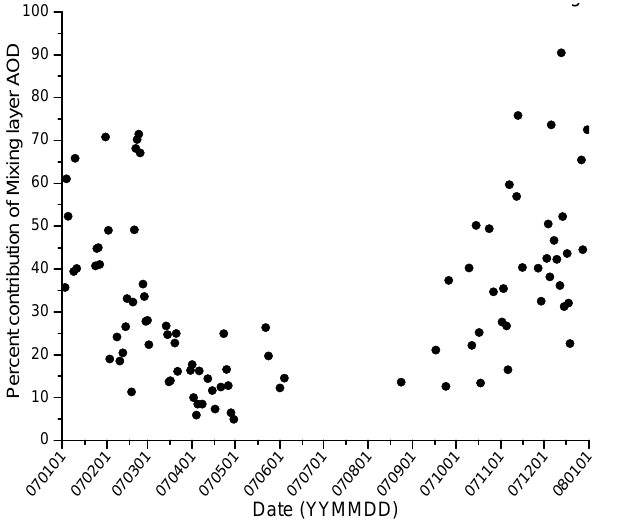
Fig. 2. Percent contribution of mixing layer aerosol to column op- tical depth.